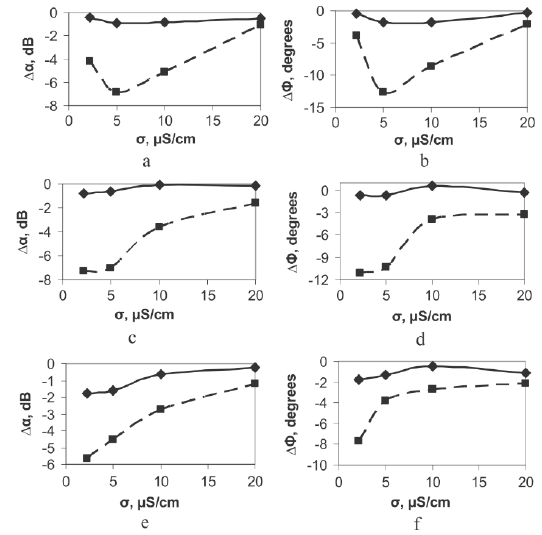
Figure 8. The change in the insertion loss ( ∆α , left) and phase of the output signal ( ∆Φ ) of the conductivity of the buffer solution. ( a , b ) 10 4 cells/mL, ( c , d ) 10 6 cells/mL, and ( e , f ) 10 8 cells/mL. The solid and dotted lines correspond to the electrically open and shored channels, respectively. Reproduced from [52], with permission from Elsevier, 2018.